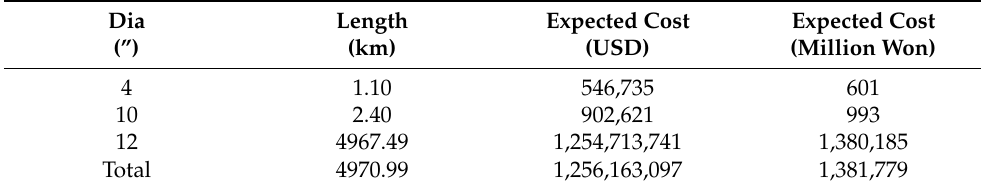
Table 6. Expected cost of hydrogen pipeline construction based on Scenario